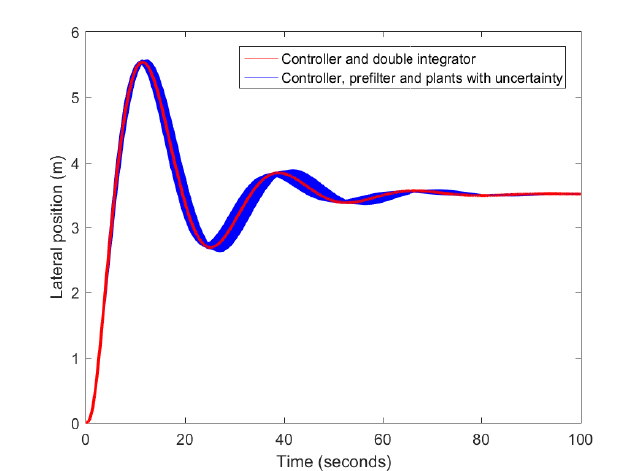
Figure 13. Comparison between the controller loops of the prefiltered and the ideal